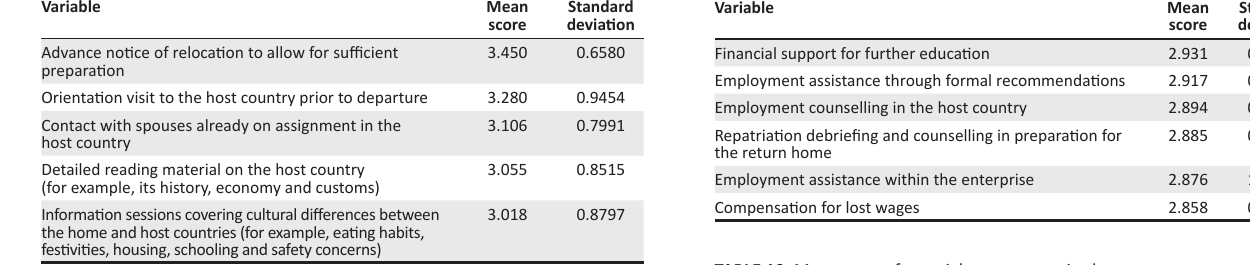
TABLE 10: Mean scores for social support required.